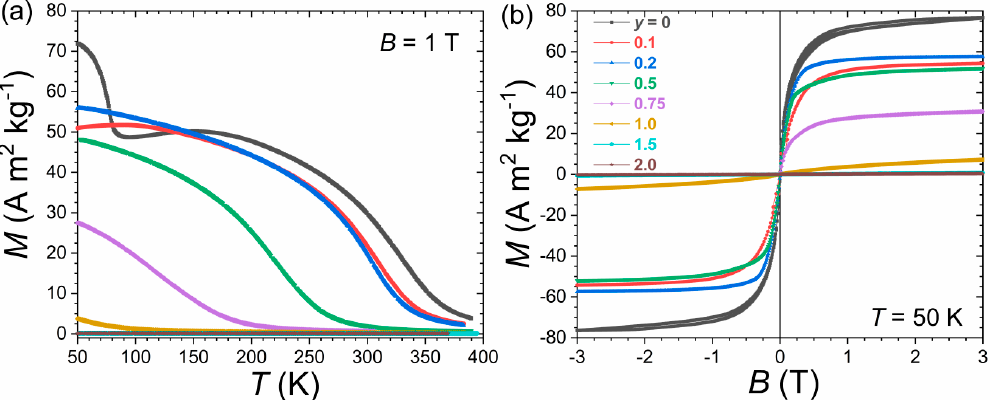
Figure 7. Magnetic properties of Sc 0.28 Ti 0.72 Fe 2 − y Mn y alloys as a function of Mn content ( y ): ( a ) M ( T ) in B = 1 T upon heating, and ( b ) M ( B ) curves at T = 50 K.